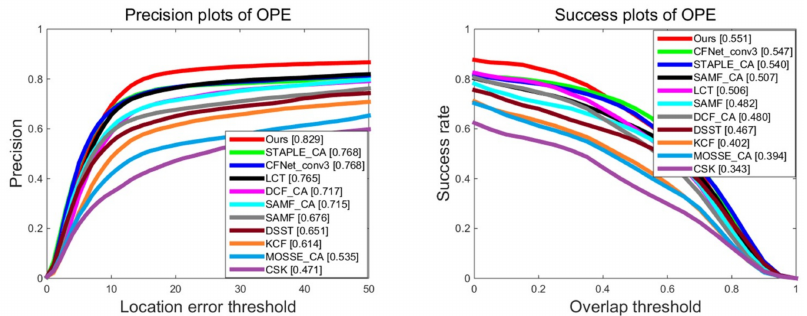
Figure 3. The overall results of distance precision and overlap success plots comparing the proposed tracker with state-of-the-art correlation filter (CF) based trackers on OTB-50 benchmark dataset using OPE.